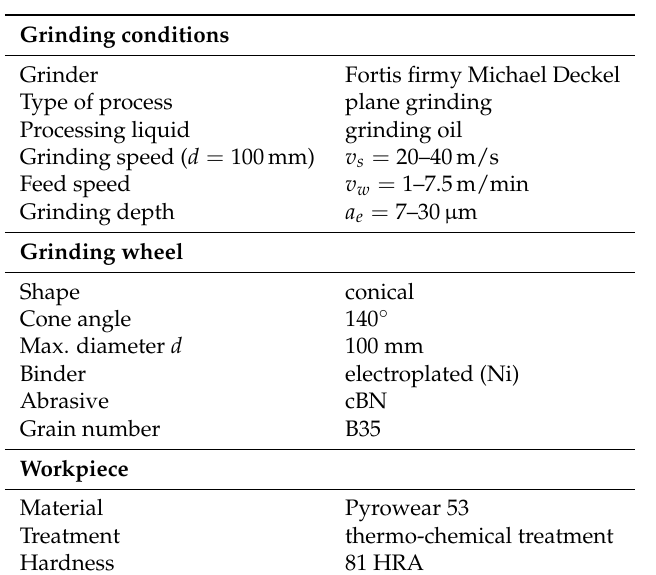
Table 1. The most important investigated